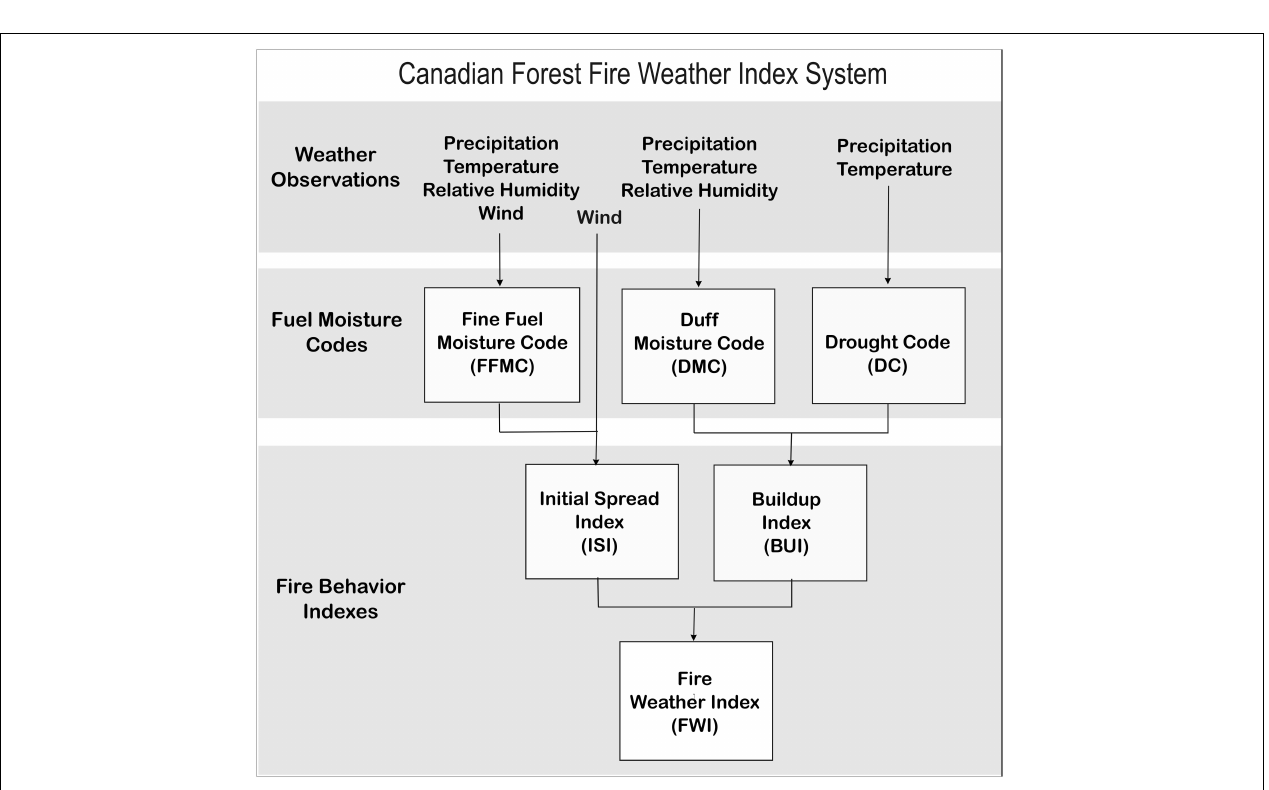
FIGURE 3 | Structure diagram of the Canadian Fire Weather Index (FWI) System. Reprinted from Taylor and Alexander (2006).